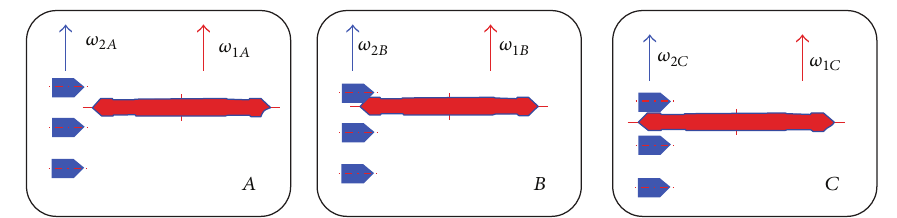
Figure 5: The movement positions of the shift sleeve in shifting process.